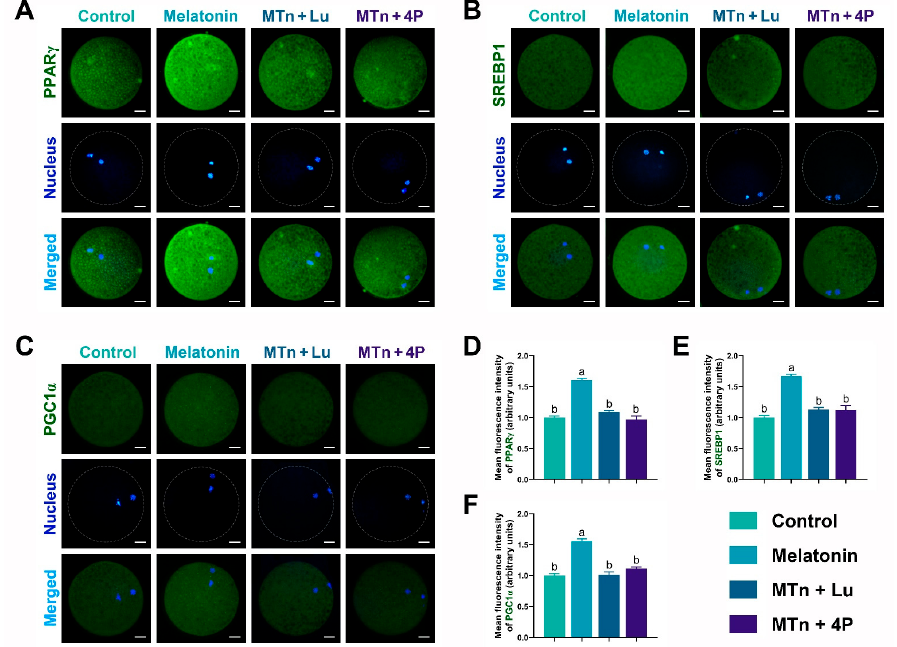
Figure 5. Lipogenesis and mitochondrial biogenesis-related protein expression in oocytes. ( A , D ) PPAR γ , ( B , E ) SREBP1 and ( C , F ) PGC1 α . Melatonin/MTn, 10 − 9 mol/L melatonin; Luzindole/Lu, 10 − 9 mol/L Luzindole; 4P-PDOT/4P, 10 − 9 mol/L 4P-PDOT. Scale bar = 25 µ m. Different letters denote significant difference ( p < 0.05).